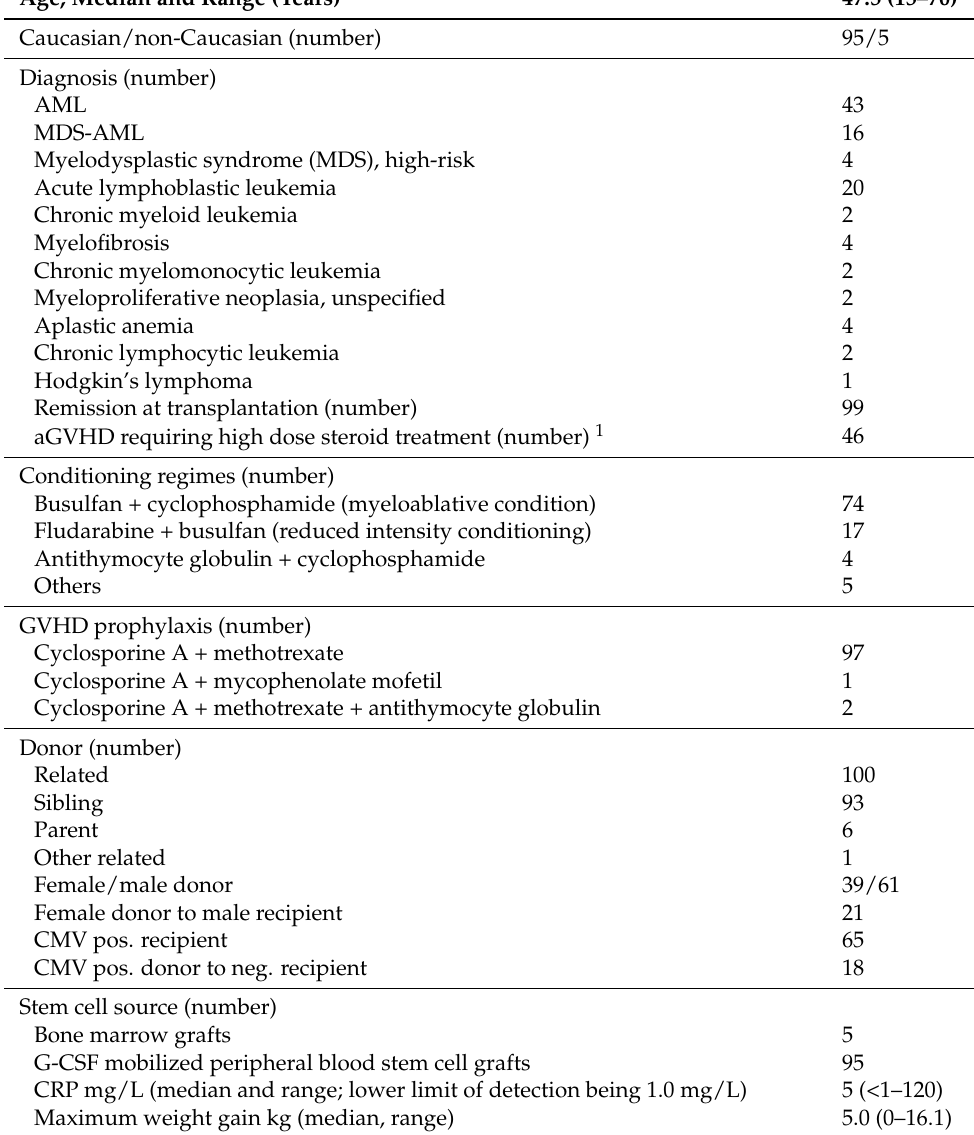
Table 1. Clinical and laboratory characteristics of the 100 allotransplant recipients included in the study. Age, Median and Range